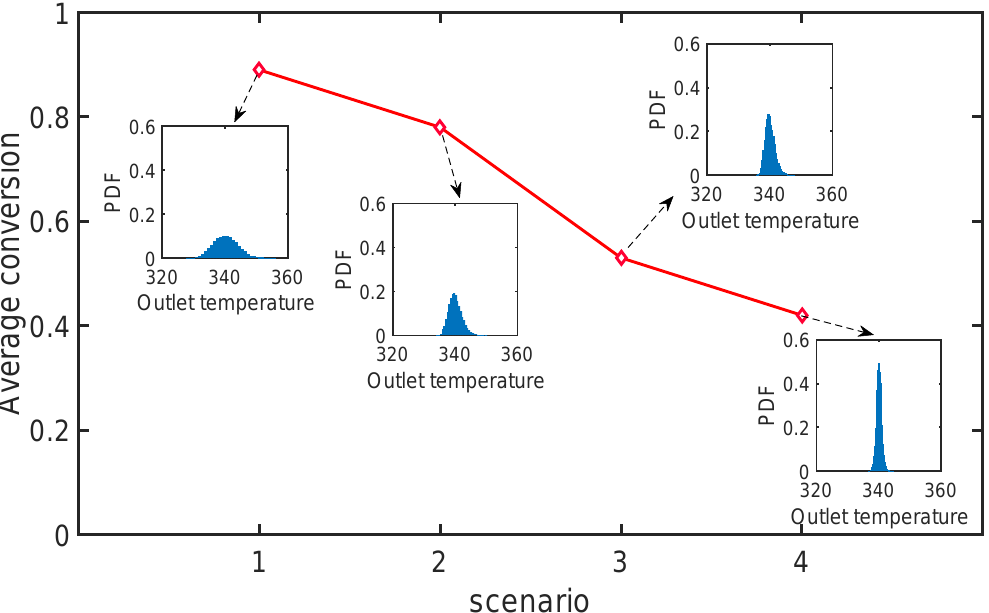
Figure 10. The average conversion of reactant A and the probability density function of the outlet temperature for four scenarios that have different relaxation factors δ eq and tolerance factors ε eq . 1: δ eq = 5, ε eq = 10%, 2: δ eq = 5, ε eq = 1%, 3: δ eq = 2, ε eq = 10%, 4: δ eq = 2, ε eq =